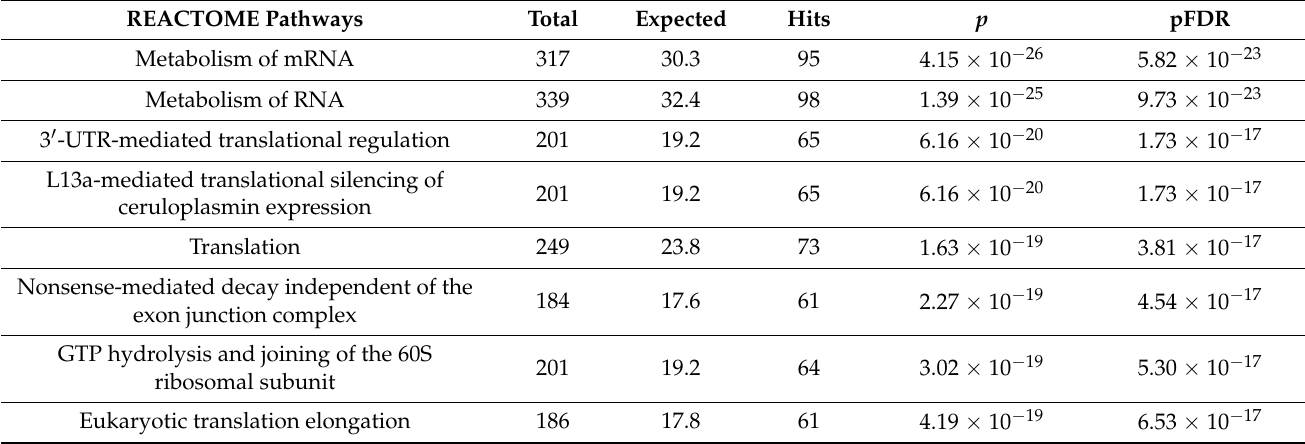
Table 6. REACTOME pathways and PANTHER biological processes statistically over-represented in the DEPs/gene list of death due to stroke.